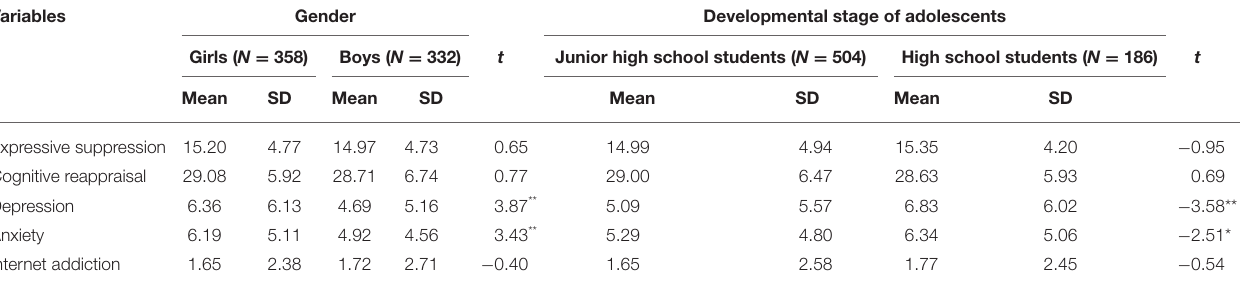
TABLE 1 | Descriptive statistics among the variables. Variables Gender Developmental stage of adolescents